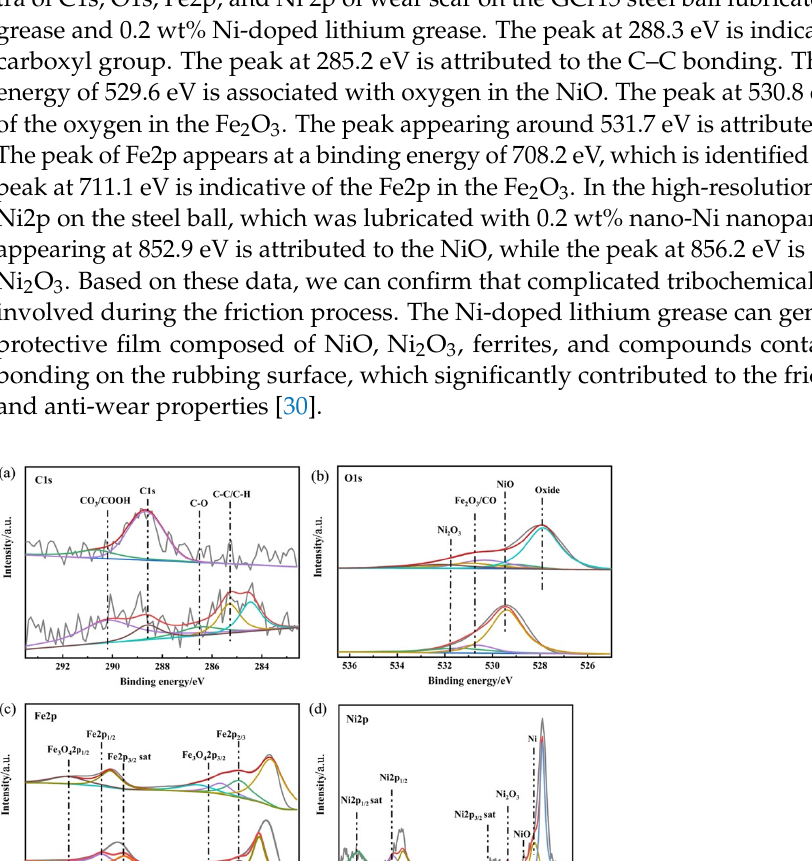
Figure 8. EDS mapping images of the worn mark surfaces after four-ball test lubricated by ( a , b ) lithium grease; ( c , d ) 0.2 wt% Ni-doped lithium grease.